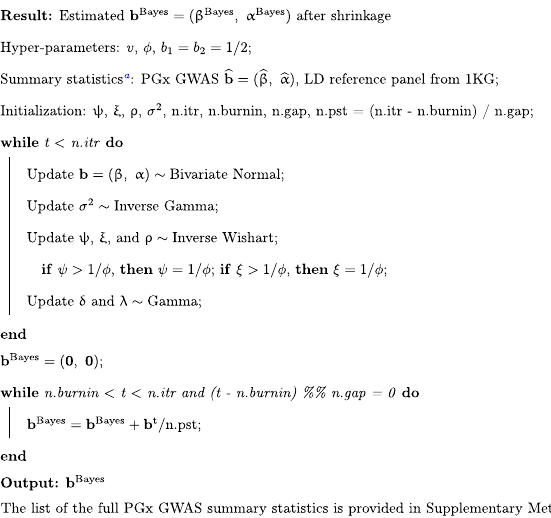
Algorithm 1 . PRS-PGx-Bayes: Performed within each LD